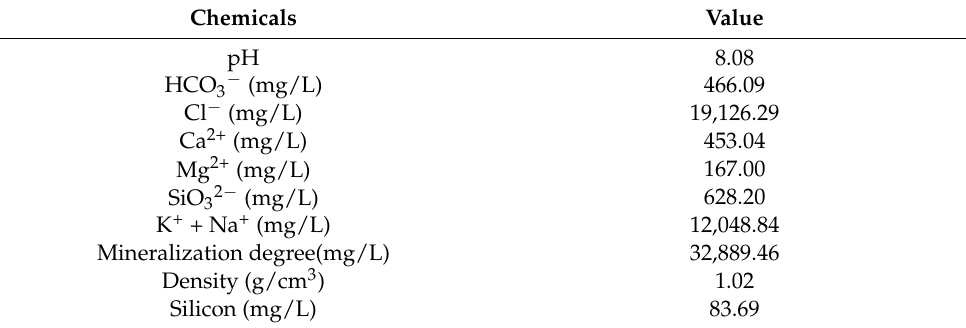
Table 1. Ion contents of wastewater from the Hongshan Oilfield.